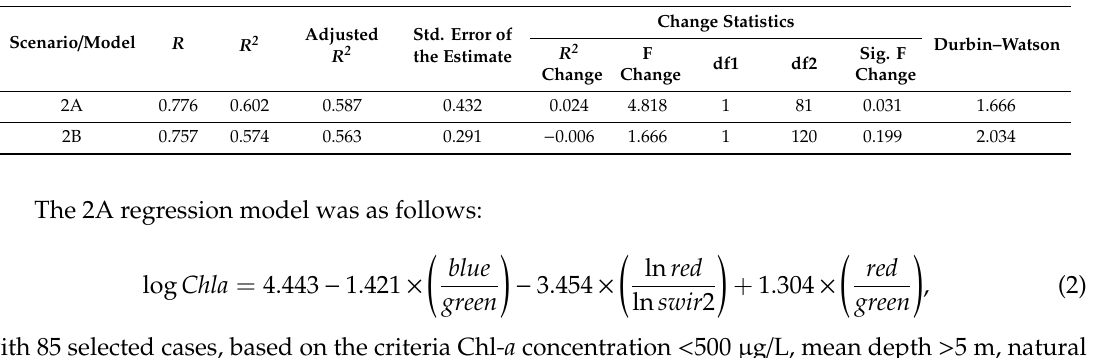
Table 9. Regression analysis statistics and model summary among reflectance values and log chlorophyll- a concentrations (dependent